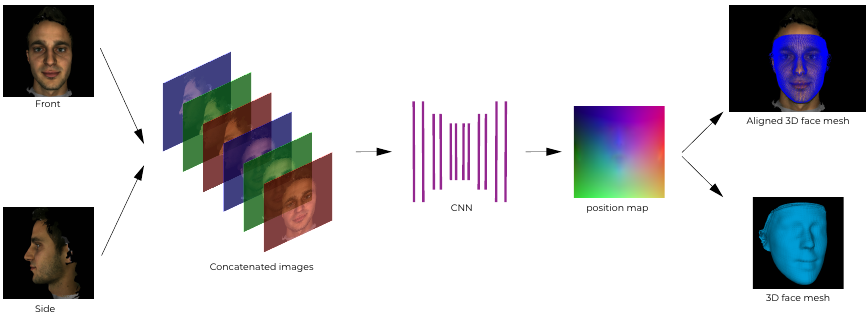
Figure 11. The proposed 3D facial reconstruction pipeline using an image pair. Network